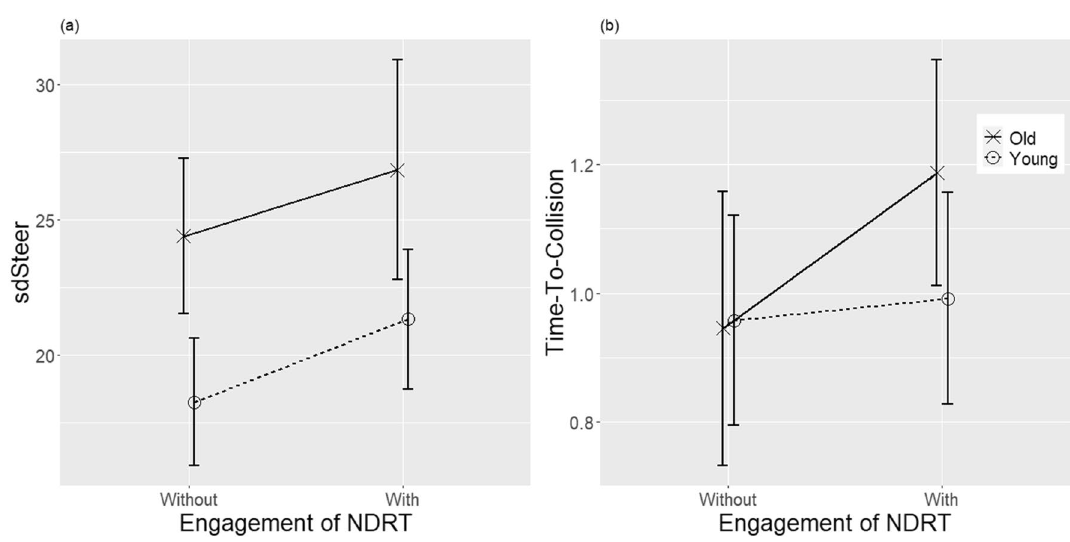
Figure 3. Differences of driving performance between age groups and the conditions of NDRT engagement, measured by ( a ) steering wheel standard deviation and ( b ) time-to-collision. NDRT: non-driving related